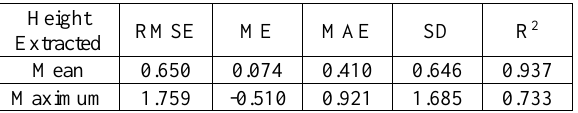
Table 2. Descriptive Statistics for Mean and Maximum Height Extraction.